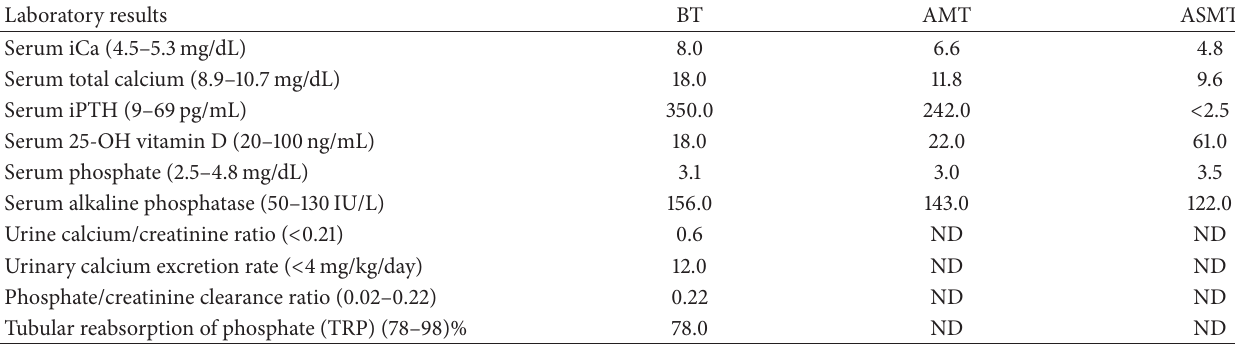
Table 1: Biochemical characteristics of our patient with